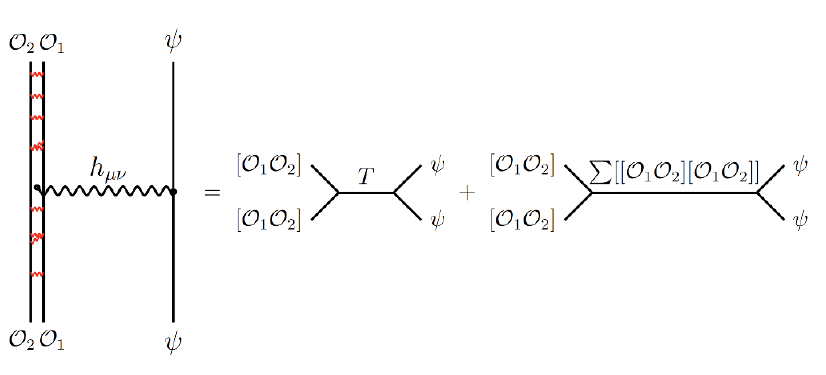
Figure 3 . The double trace operator [ like a single trace primary when bulk fields φ 1 and φ 2 are strongly